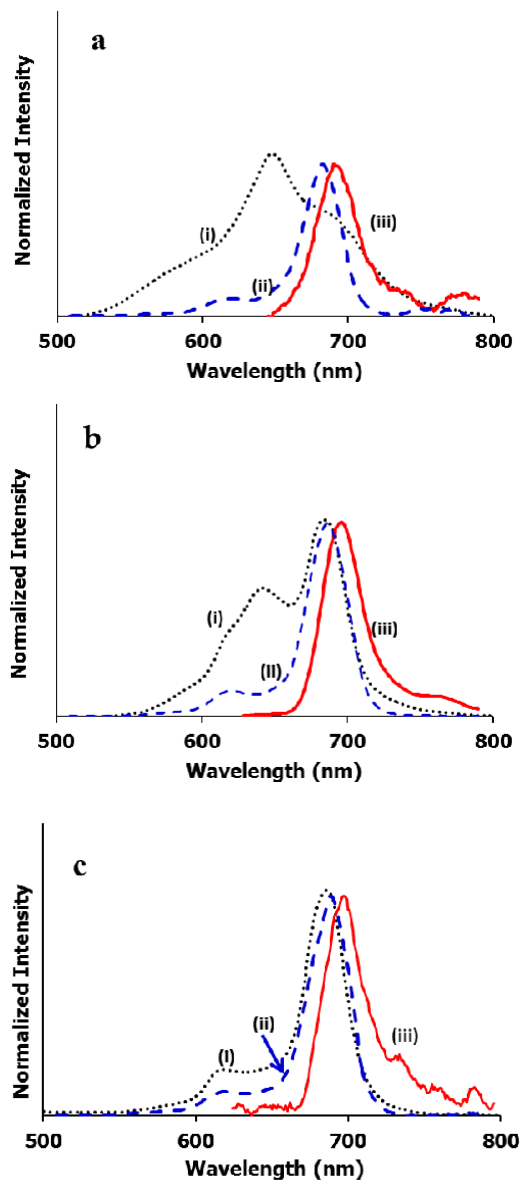
Figure 5. Normalized absorption (dotted line), fluorescence excitation (dashed line) and emission (straight line) spectra of (a) 7 in aqueous medium, (b) 6 in the presence of cremophore EL in aqueous medium and (c) 8 in